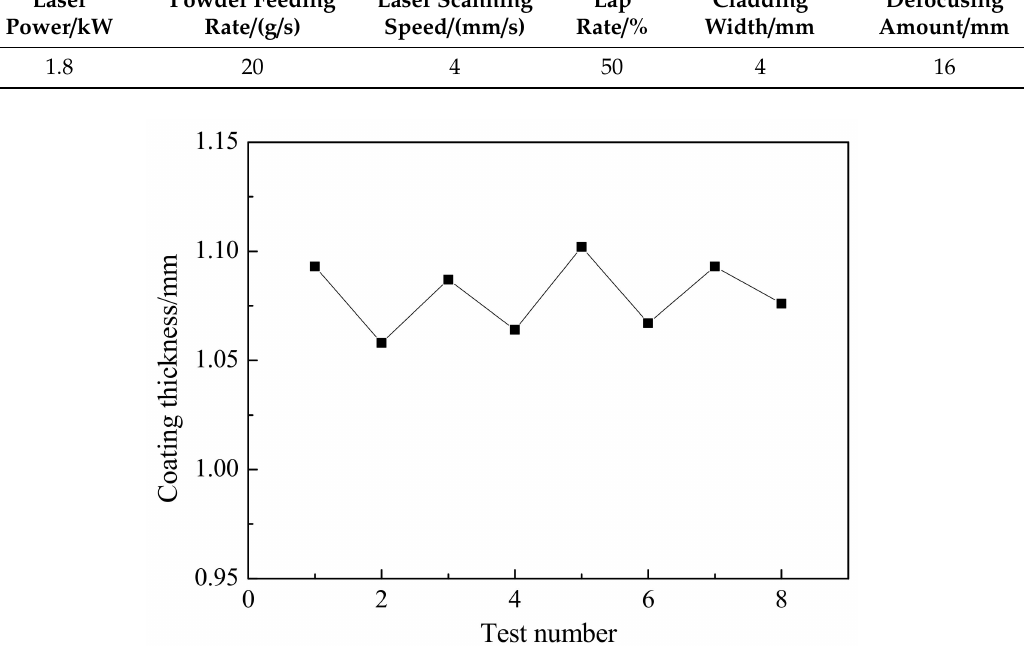
Figure 9. Thickness of cladding